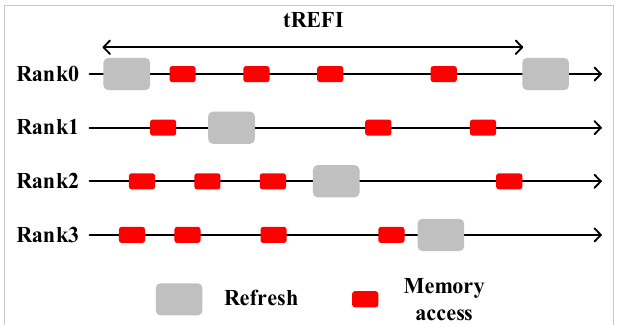
Figure 2. Staggered auto-refresh in a four-rank system.